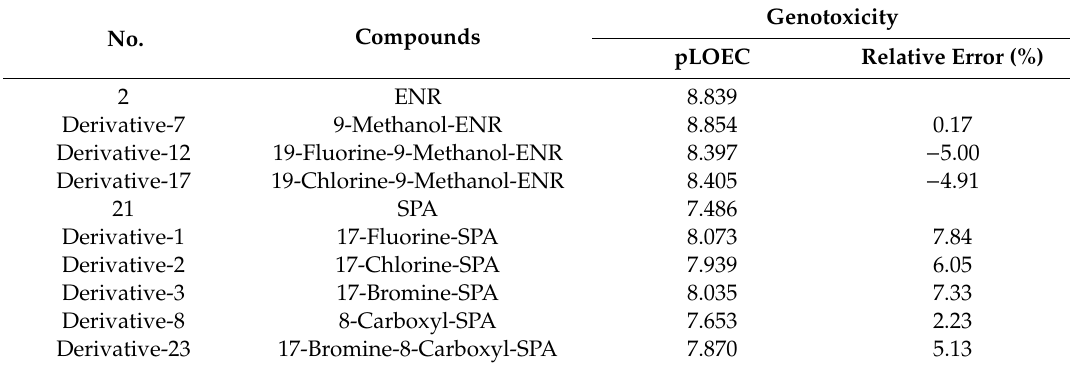
Table 6. Predicted pLOEC values of ENR and SPA